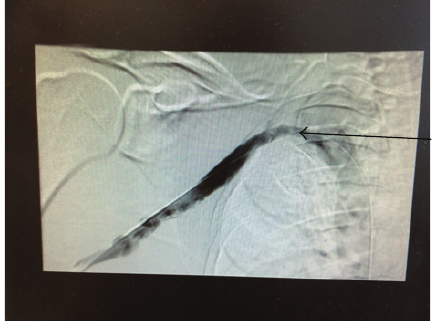
Figure 1: Another image showing extensive right upper extremity deep venous thrombosis on venogram.